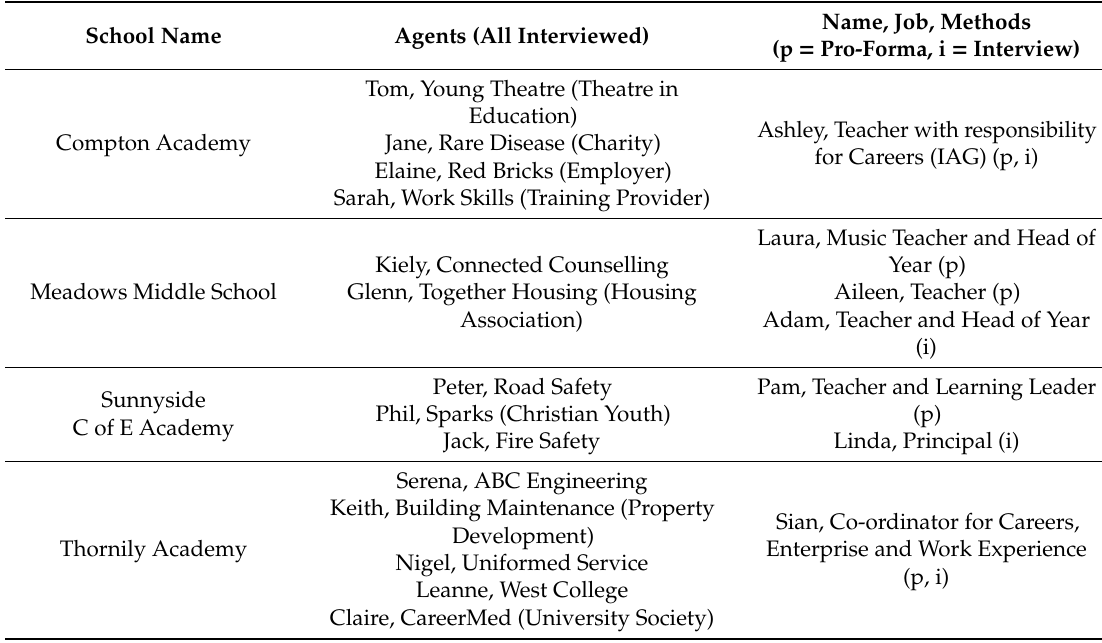
Table 1. School and agent